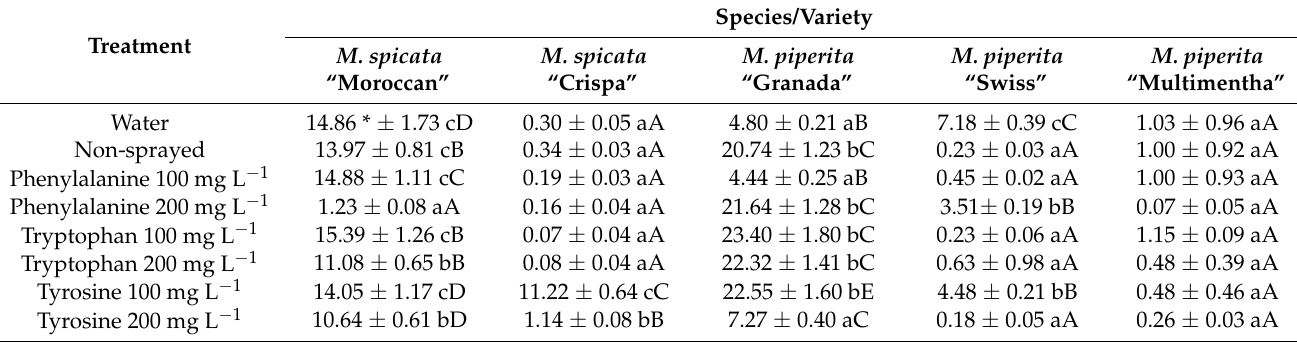
Table 7. Cinnamic acid content in mints influenced by foliar application of amino acids, mg 100 g − 1 DM in 2017–2018.